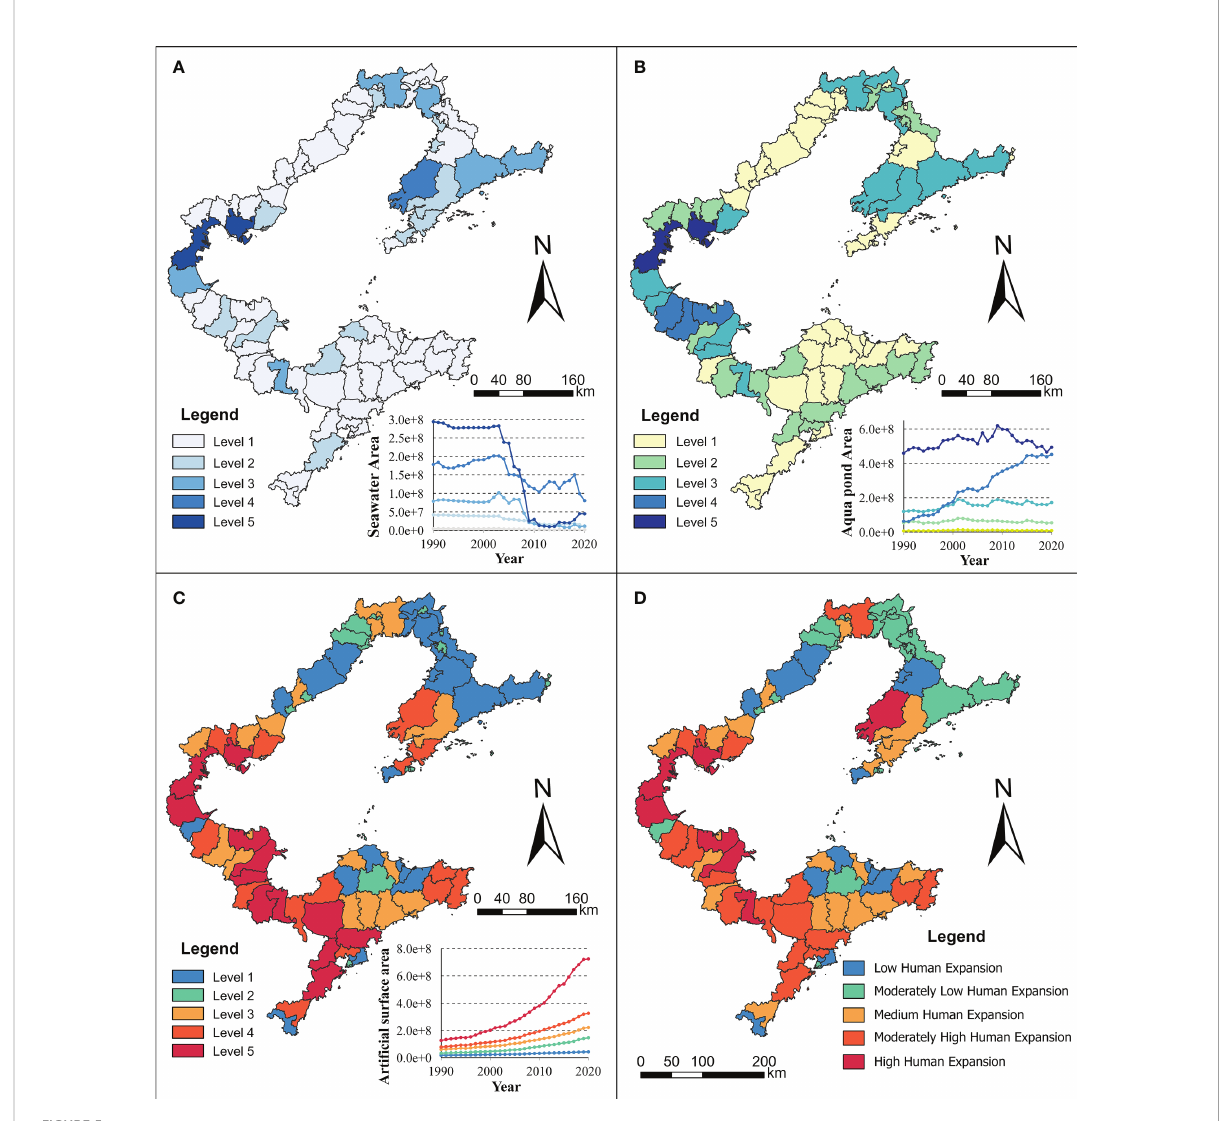
FIGURE 5 Time series clustering results of human expansion in the Circum-Bohai Coastal Zone: (A) reclamation, (B) aquaculture ponds, (C) arti fi cial surface, (D) composite expansion